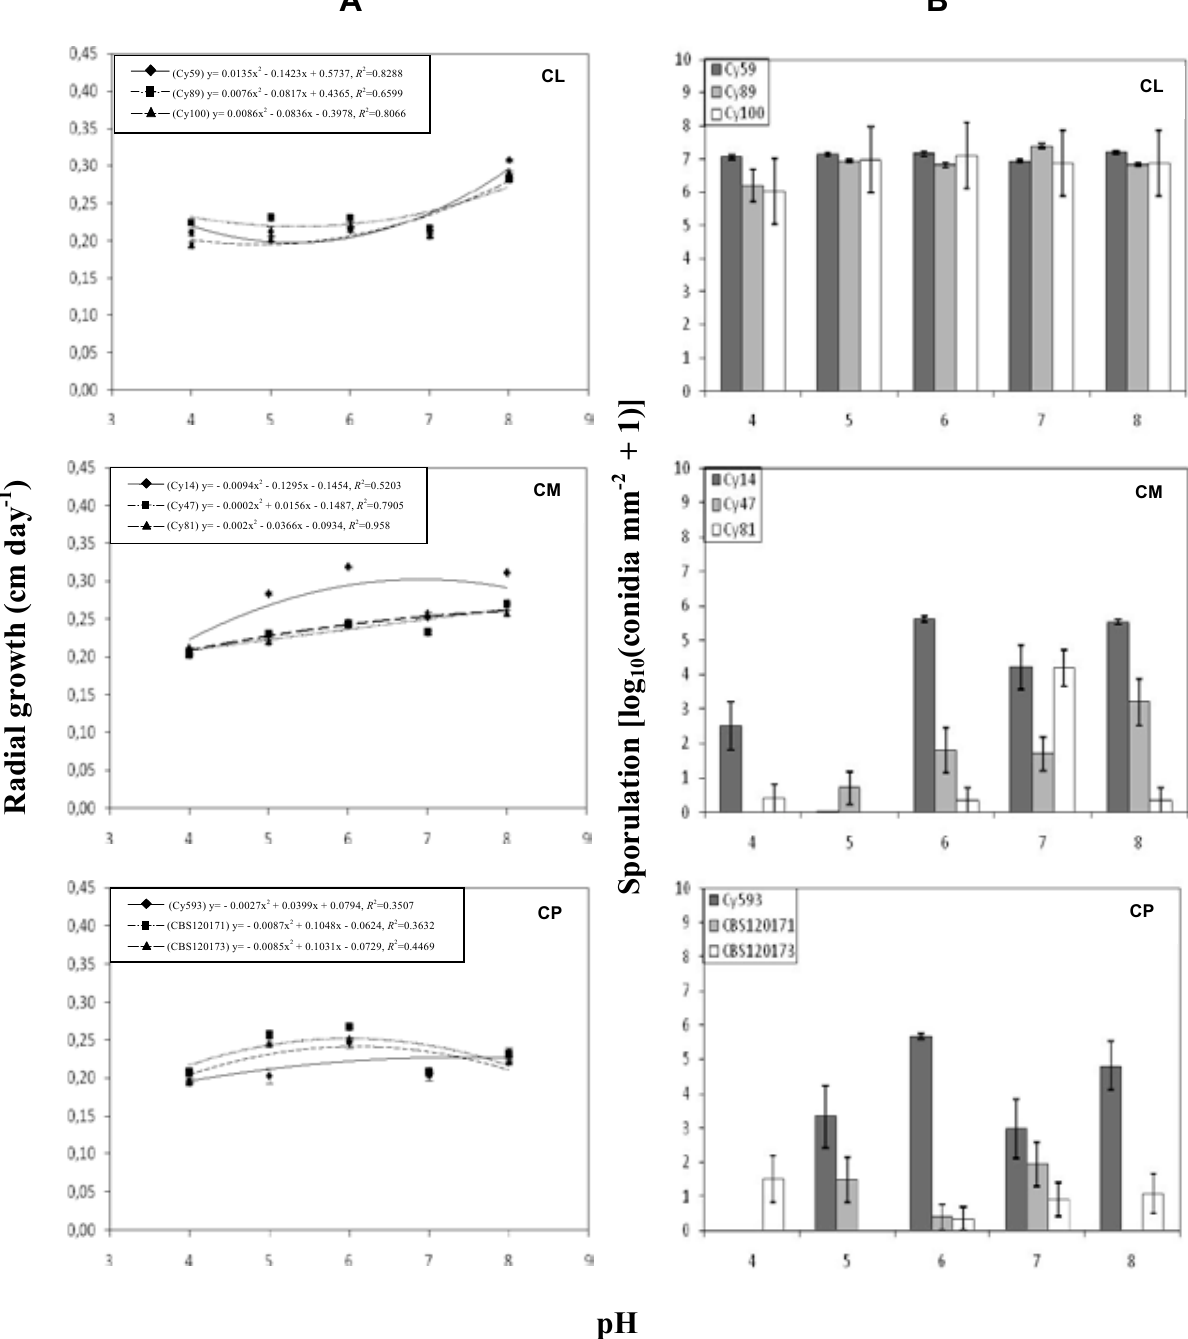
Figure 2. A, mean colony radial growth rates (cm day -1 ) of three isolates of C. liriodendi (CL) , C. macrodidymum (CM) and C. pauciseptatum (CP), after 10 days of incubation in darkness on PDA at pHs 4, 5, 6, 7 or 8; B, mean amounts of sporulation [log 10 (conidia mm -2 + 1)] of three isolates of C. liriodendri (CL) , C. macrodidymum (CM) and C. pauciseptatum (CP), after 30 days of incubation in darkness on PDA at pHs 4, 5, 6, 7 or 8 . Results are the mean of two independent sets of four pseudor - eplicates in each pH.Vertical bars are the standard error of the